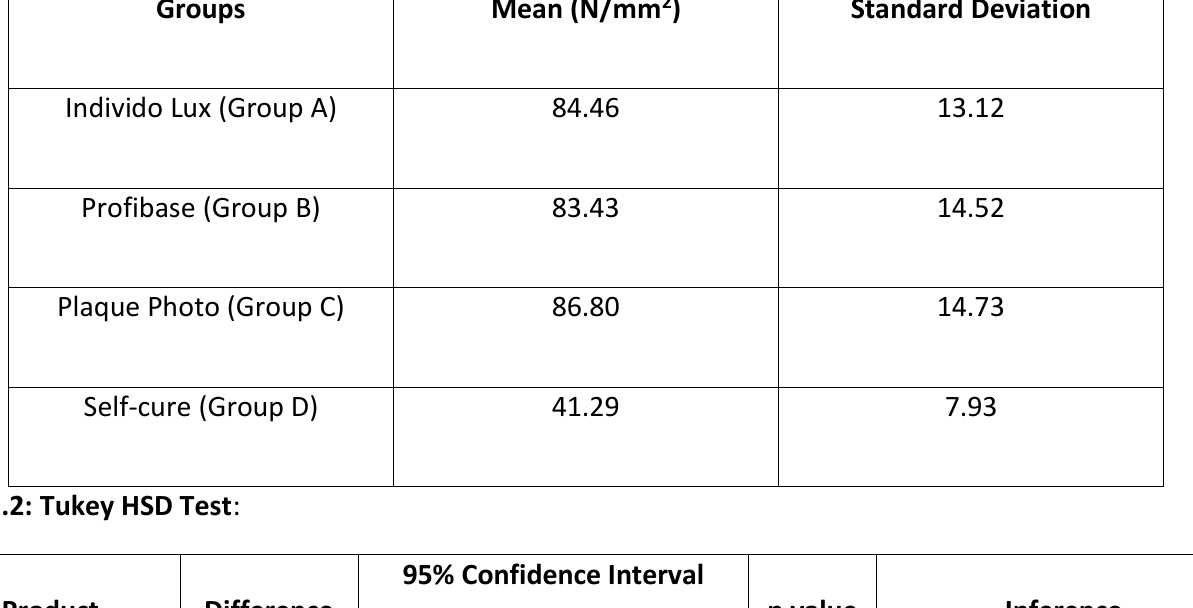
Table 1.2: Tukey HSD Test